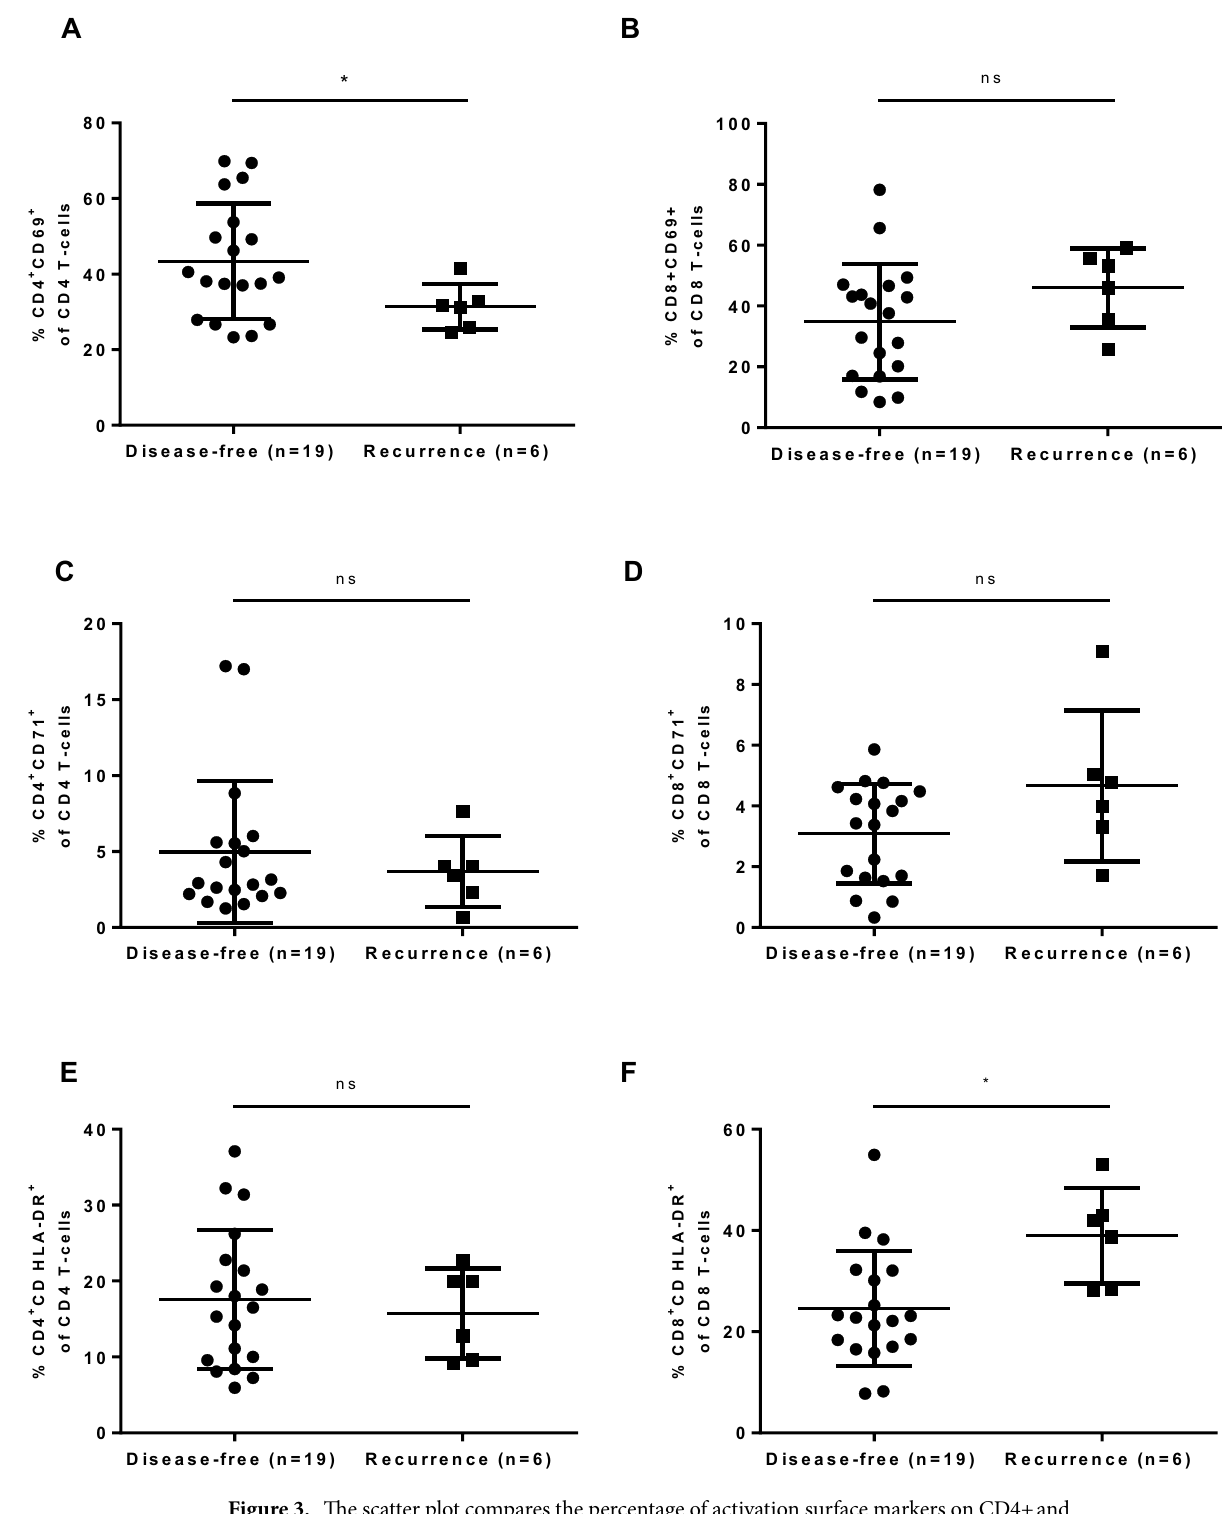
Figure 3. The scatter plot compares the percentage of activation surface markers on CD4+ and CD8+ lymphocytes expressed in sentinel nodes in relation to recurrence status. Sixteen patients contributed with 25 sentinel nodes. Four patients who contributed with 6 sentinel nodes were diagnosed with cancer recurrence during follow-up period. ( A , B , D – F ) were analysed by Unpaired t-test with Welch’s correction. ( C ) was analysed by Mann–Whitney test. *<